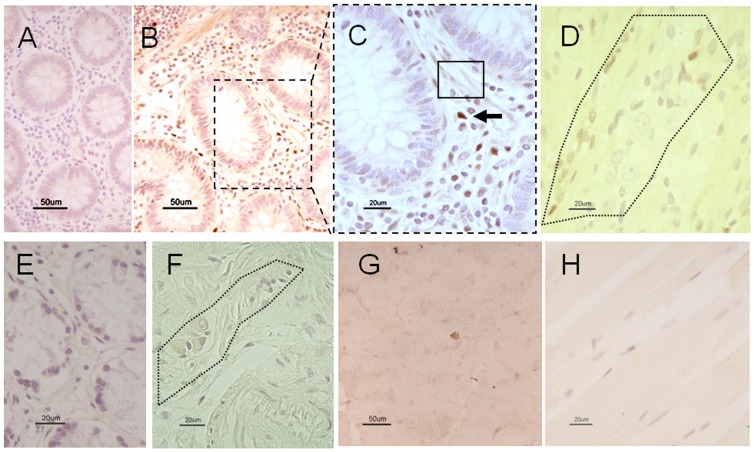
TP immunoreactivity in the duodenum and skeletal muscle of control and in a MNGIE patient.TP immunolabeling is lacking in a tissue section of normal duodenal mucosa in which primary antibody was omitted (negative control) (Figure 3A). Figure 3B (low magnification) and 3C (high magnification) show TP immunolabeling in the control mucosa. The black arrow indicates TP immunolabeled cells with features of immunocytes distributed throughout the lamina propria; the rectangle shows a less intense TP immunostaining in the cytoplasm of cells with features of fibroblasts. The dotted line area in figure 3D indicates a myenteric plexus displaying TP immunolabelling in non-neuronal cells (likely glial cells). Note the lack of TP immunolabeling in the mucosal lamina propria (Figure 3E) and myenteric plexus (dotted line) of a MNGIE patient (Figure 3F). The TP immunolabeling was negative also in normal (Figure 3G) and MNGIE (Figure 3H) skeletal muscle. Calibration bars  = 20 µm and 50 µm in 3C, 3D, 3E, 3F, 3H and 3A, 3B, 3G respectively.